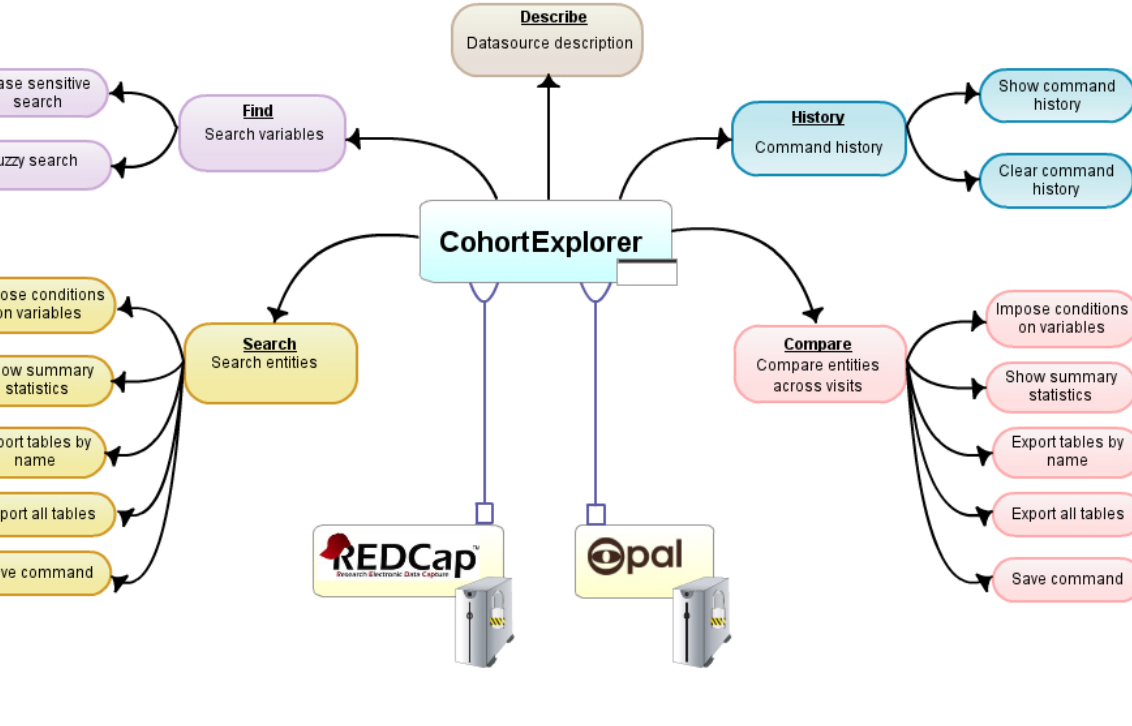
Figure 1. Using the datasource API, CohortExplorer, via the authentication mechanism, is able to connect to secure EAV clinical repositories such as REDCap and Opal. The connection made to the clinical repository is expected to be read-only. Once connected, the user can explore the datasources stored within the repositories using the abstracted command line search